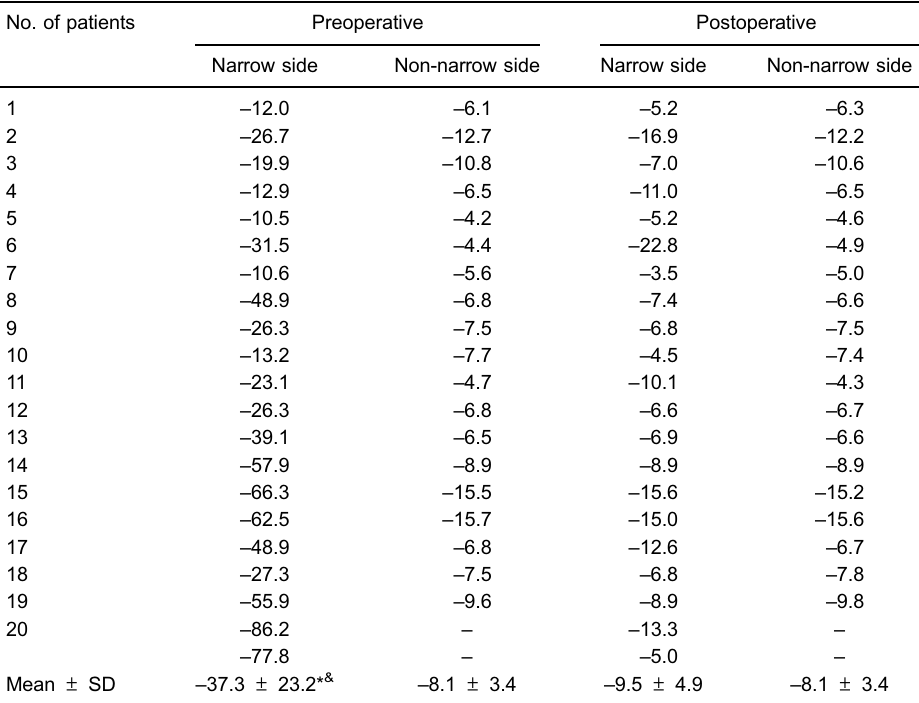
Table 3. Pressure on the cross-section of the nasal valve area in 20 patients (in